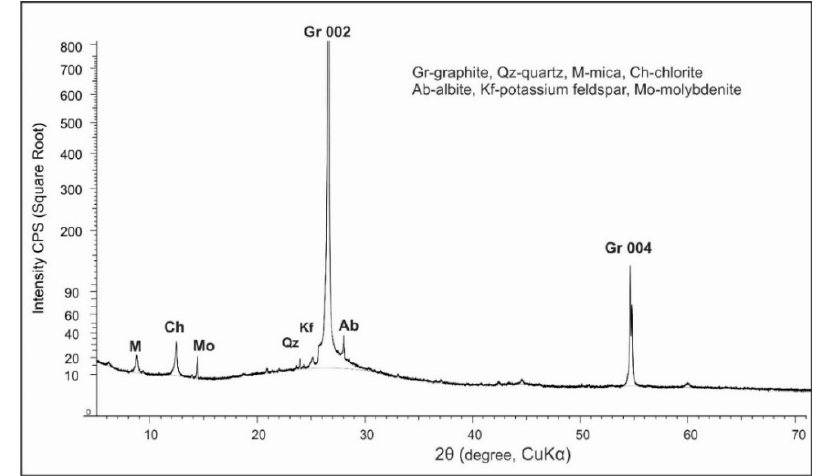
Figure 2. X-ray Powder Diffraction (XRD) pattern of the sample N4442017_R7.